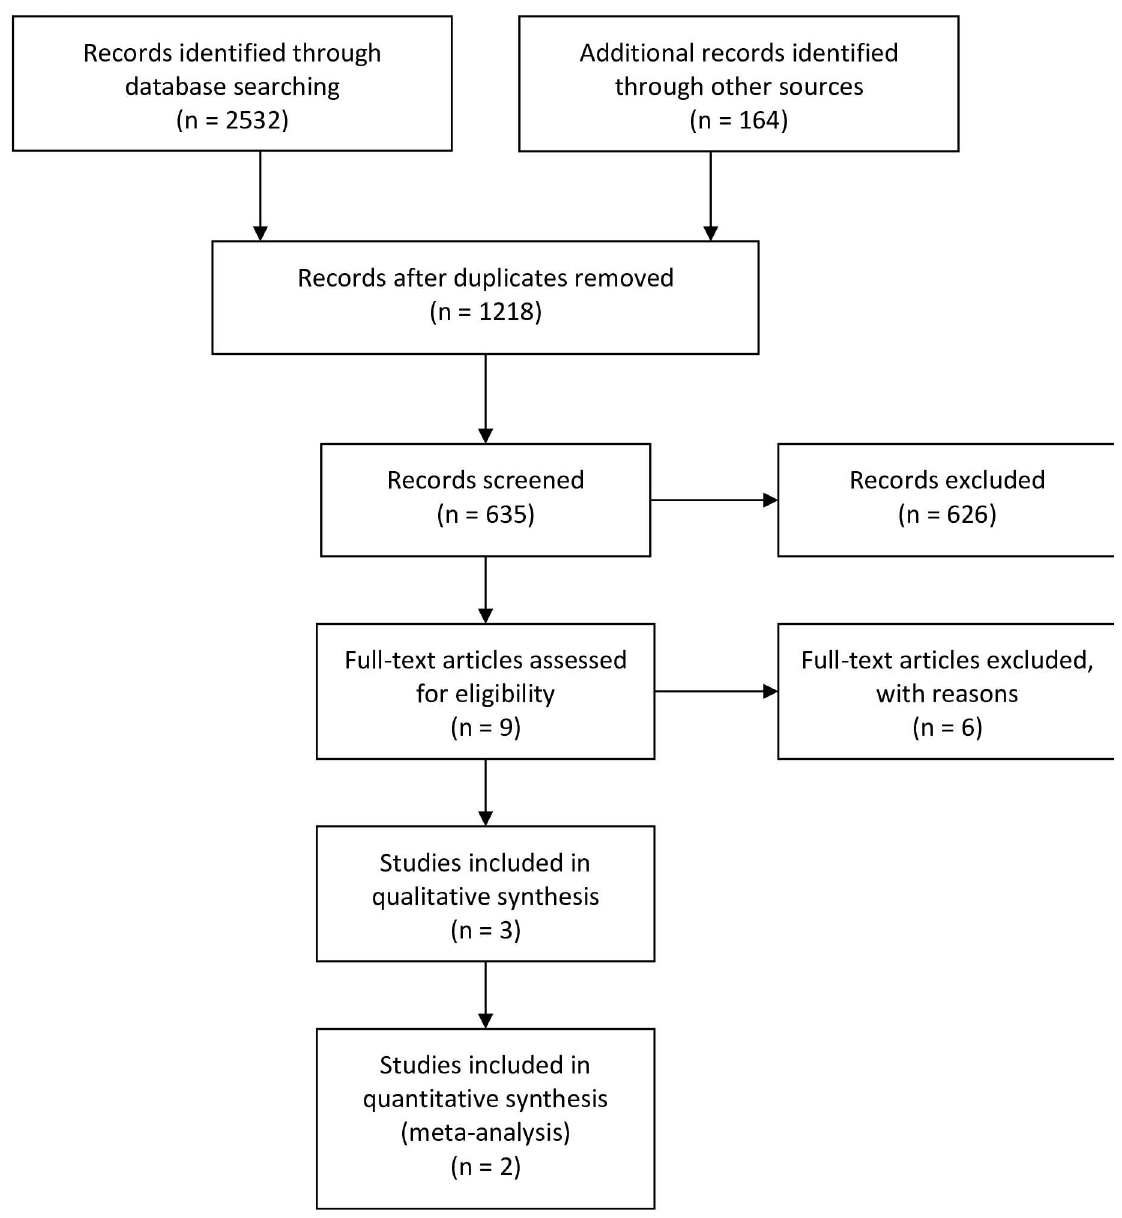
Fig 2. PRISMA flow chart of study selection. N = number of